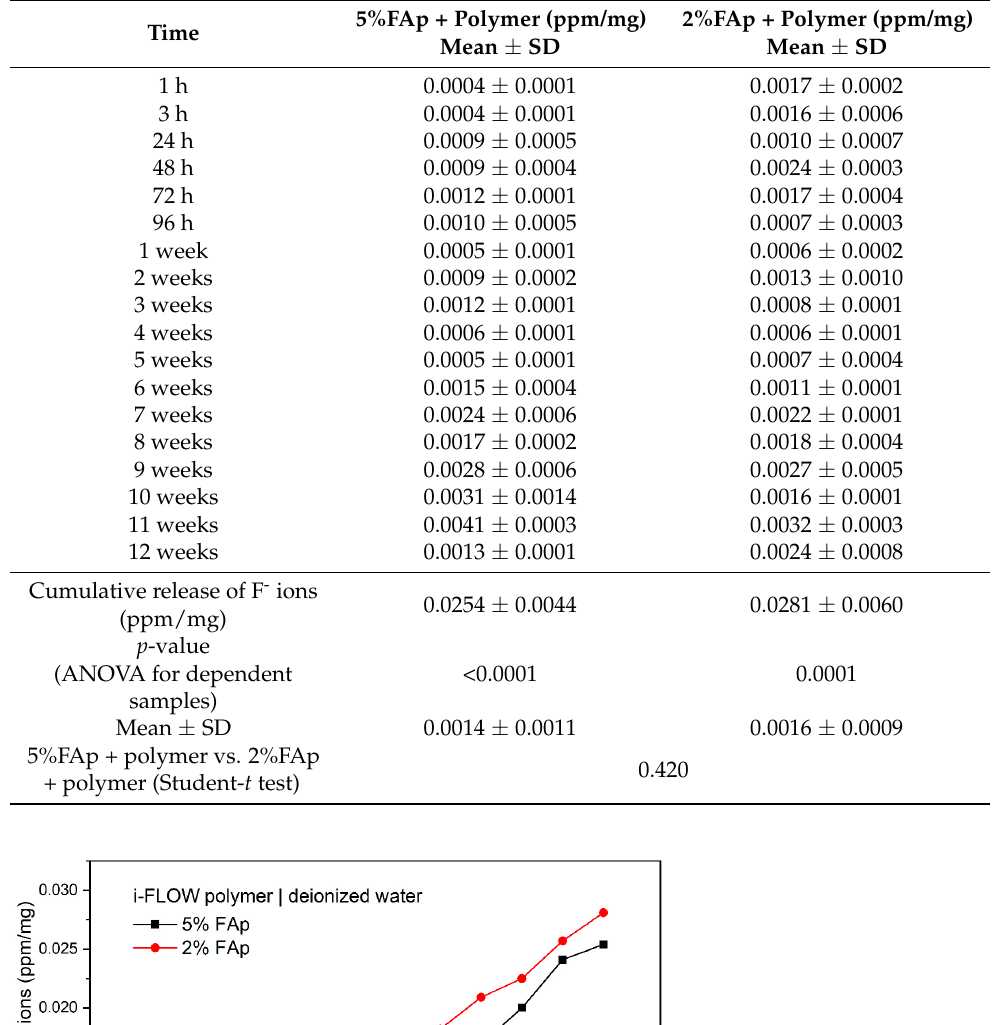
Table 2. Release of fluoride ions (ppm/mg) from 5%FAp + polymer and 2%FAp + polymer materials into deionized water.